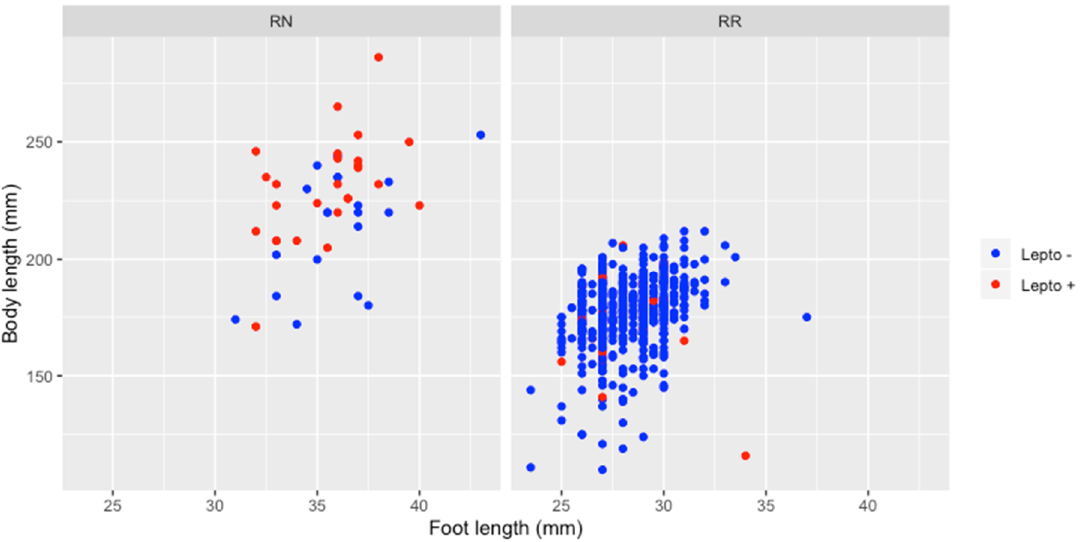
Figure 2. Relation between animal size (regarding body and foot length) and Leptospira infection, for Rattus norvegicus and Rattus rattus.